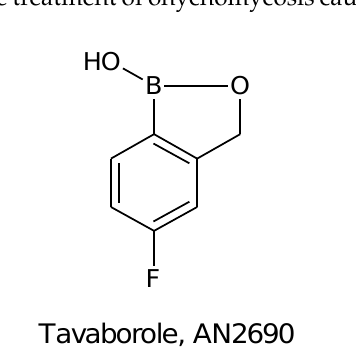
Figure 1. The structure of Tavaborole (AN2690), active ingredient of Keridin–antifungal drug approved by FDA in 2014 for the treatment of onychomycosis.